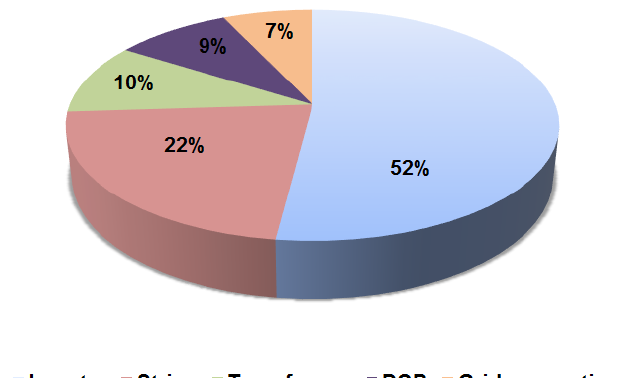
Figure 10. Contribution to EL in a potential CI system where inverter and transformer repair is pro-actively managed.